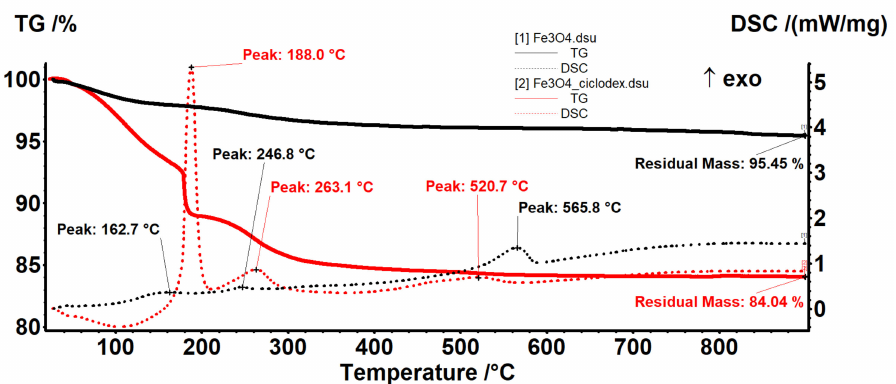
Figure 4. Thermal analysis for Fe 3 O 4 and Fe 3 O 4 @ β -CD nanopowder.